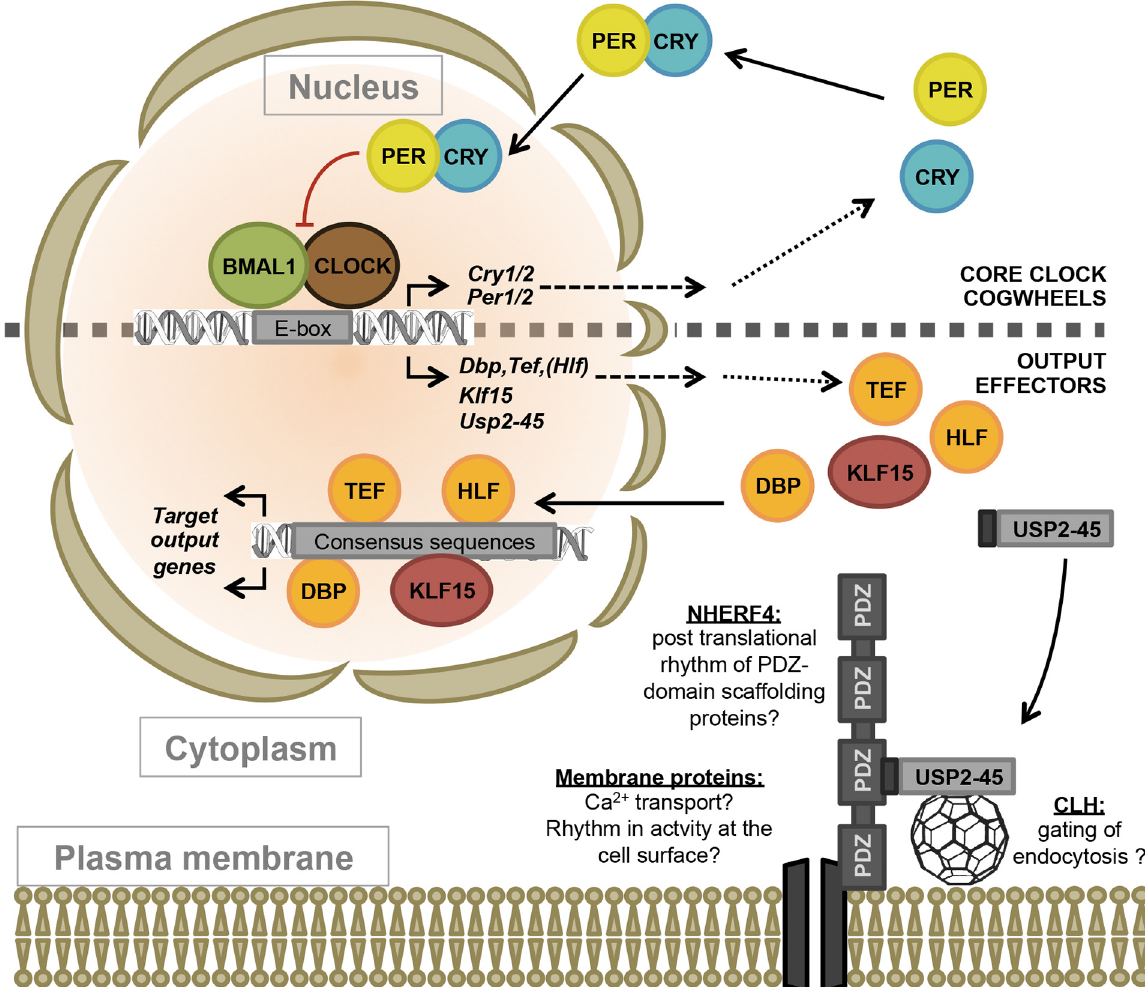
Fig 7. Proposed model of body-wide clock output effectors. Based on the data presented above, USP2-45 becomes the first non-transcriptional clock output effector along with DBP, TEF, HLF and KLF15. Given the biochemical location of USP2-45 in membranes and its action on NHERF4 in vivo and its interaction with NHERF4 and the ubiquitous CLH in vitro , we propose that USP2-45 may act similarly in other tissues. Possible role could be related to Ca 2+ transport across the cell membrane, indirect rhythmic regulation of membrane protein function by PDZ-domain containing scaffolds or circadian gating of cell sensitivity to circulating cues by rhythmic